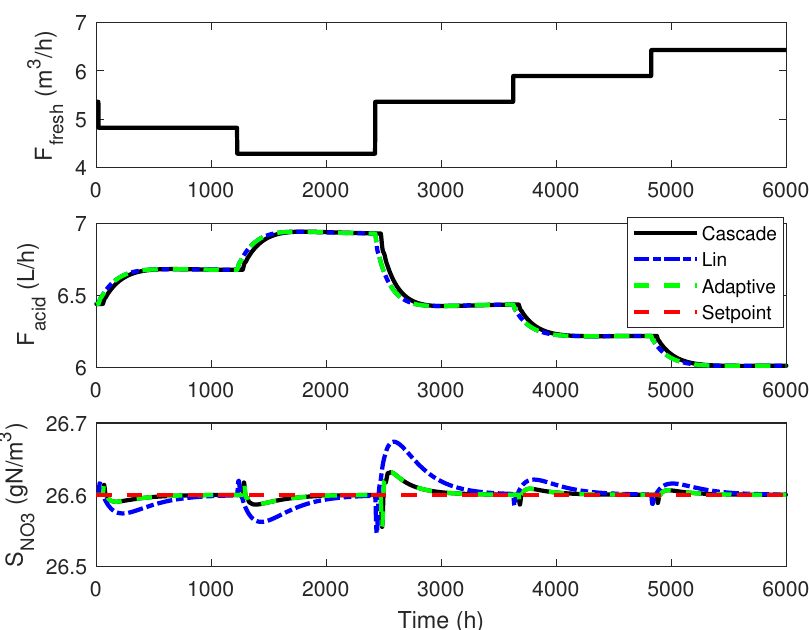
Figure 17. Nitrate concentration and acid flowrate evolutions for 5 to 10% variations in fresh water flowrate ( F fresh ) using different controllers: cascade ( Cascade ), classical linearizing ( Lin ) and adaptative linearizing controllers ( Adaptive ).